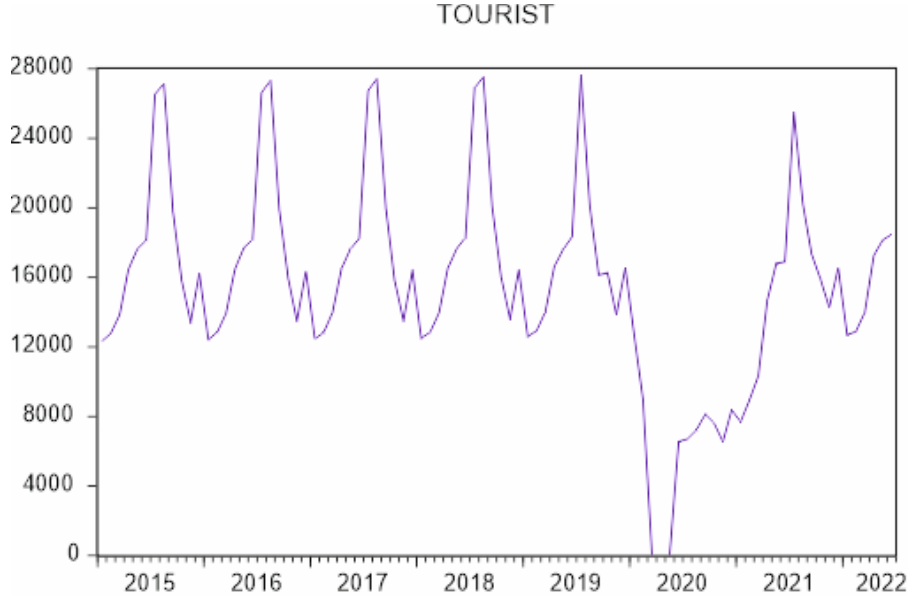
Figure 4. Monthly evolution of the number of gastronomic tourists in Córdoba (January 2015 to June 2022). Source: own elaboration based on information from the Designations of Origin of Córdoba. * Vertical axis is thousands of people.